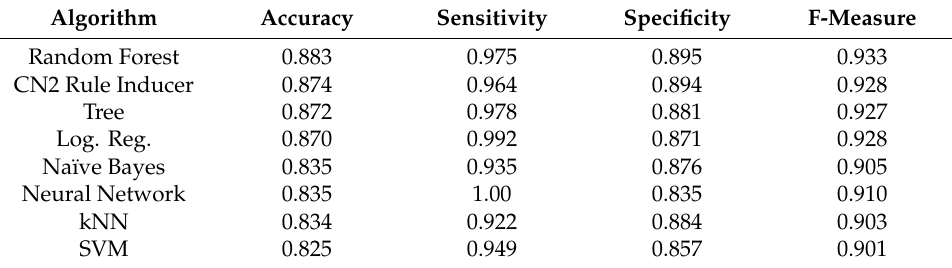
Table 7. Data transformation (equal width), feature selection (information gain